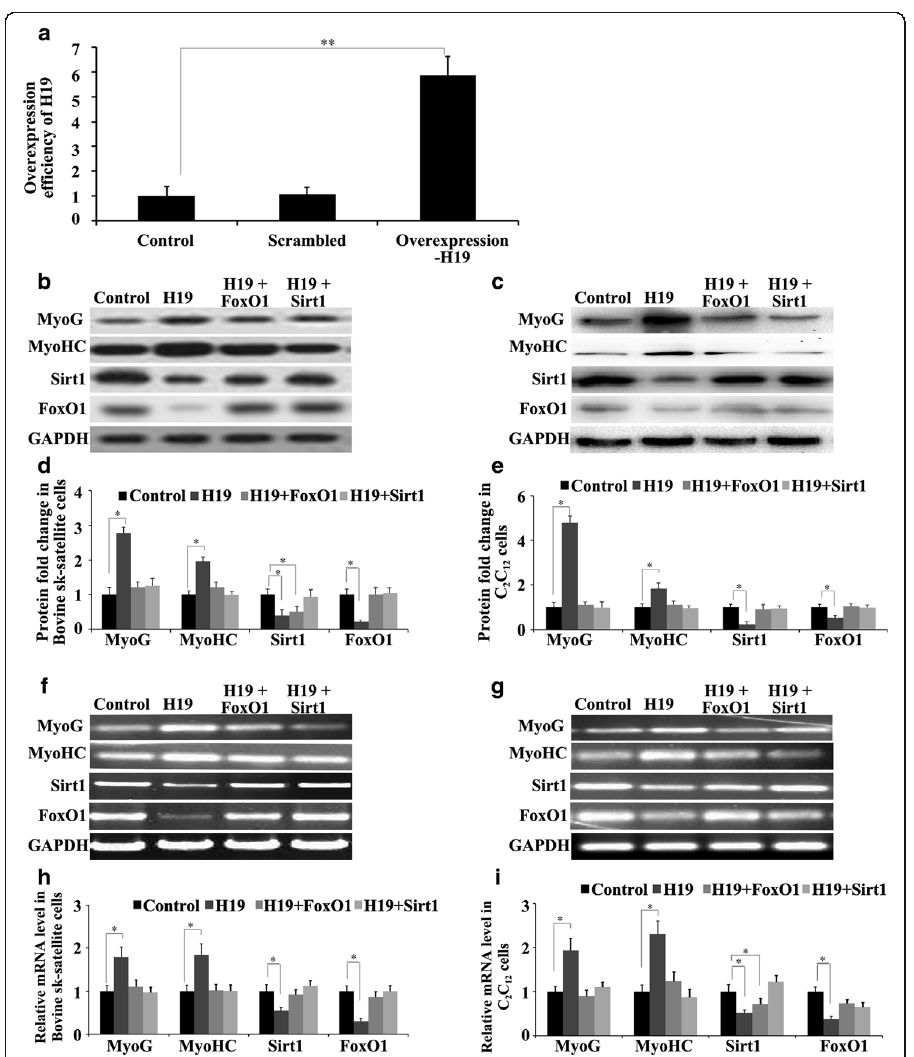
Fig. 4 Sirt1/FoxO1 overexpression neutralized myoblast inhibition by H19. a The overexpression efficiency of H19. Cells without H19 transfection (scrambled) were the negative control and wild-type cells were the blank control (control). The protein levels of MyoG, MyHC, Sirt1 and FoxO1 in bovine tibia skeletal muscle (sk-muscle) satellite cells ( b and d ) and C 2 C 12 cells ( c and e ) with H19 overexpression. f , g RT-PCR results for bovine sk-muscle satellite cells ( f ) and C 2 C 12 cells ( g ) with H19 overexpression. h , i Real-time qPCR results for bovine sk-muscle satellite cells ( h ) and C 2 C 12 cells ( i ) with H19 overexpression. The cells transfected with the vector without H19 (scrambled) were the control and GAPDH was the internal control. The protein and mRNA abundance was normalized to the GAPDH gene, n = 3, * p < 0.05, ** p <